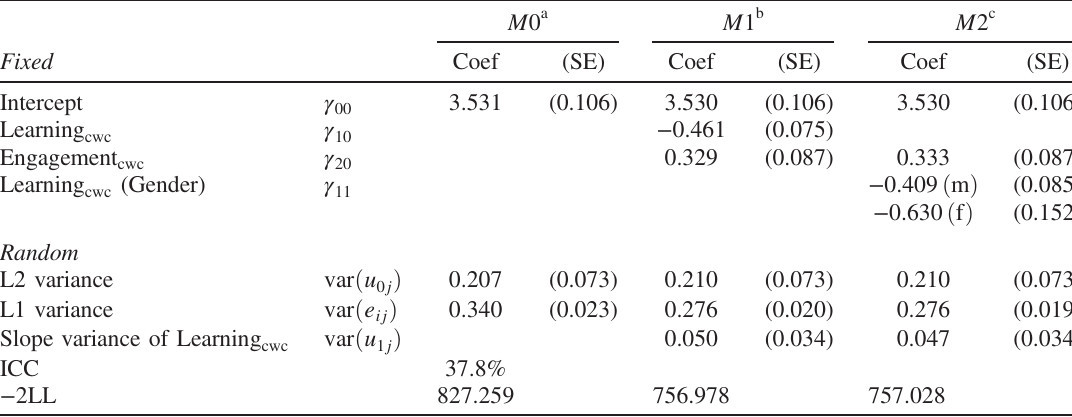
TABLE II. Enhancers as the outcome for three different models. The values presented in the table are all statistically significant ( p < 0 . 05 ), the significance of slope variance was tested with chi-square test using − 2